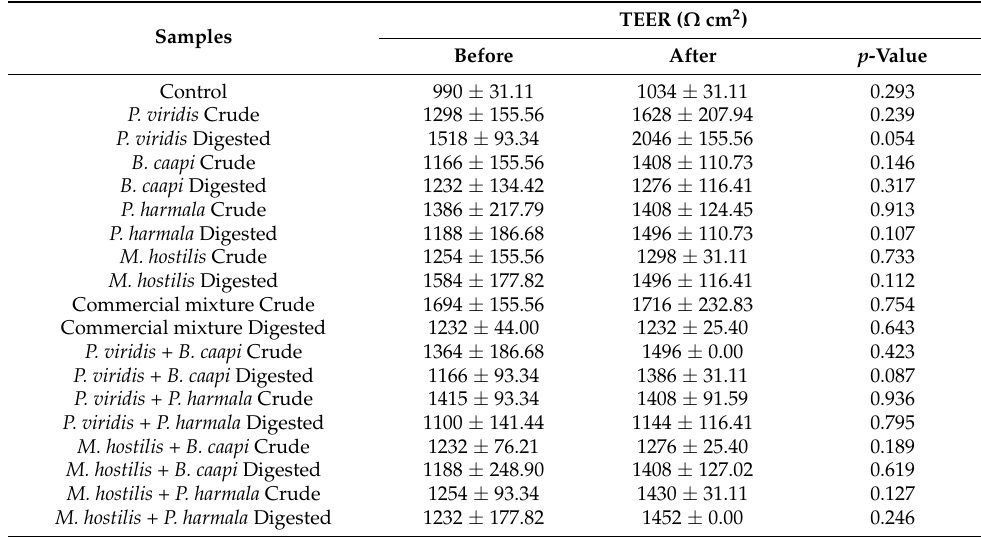
Table 4. TEER values obtained before and after incubation with the extracts. The values are expressed as mean ± SD. Statistically significant values were considered if p < 0.05